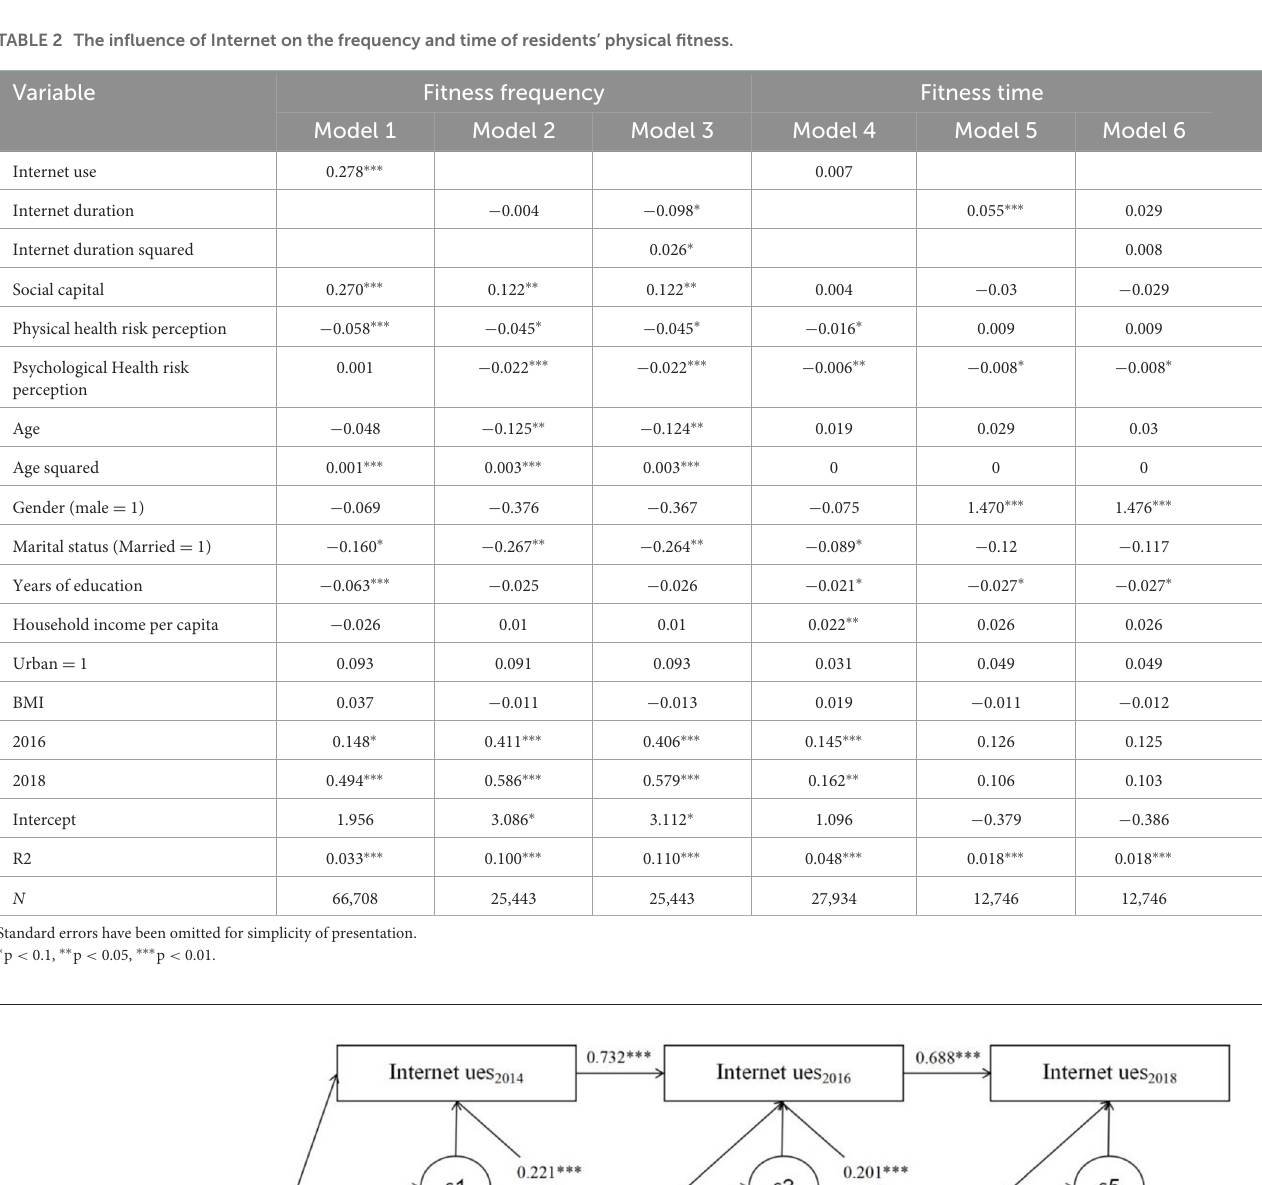
FIGURE1 The estimation of the cross lagged panel model of the internet use and physical fitness frequency.